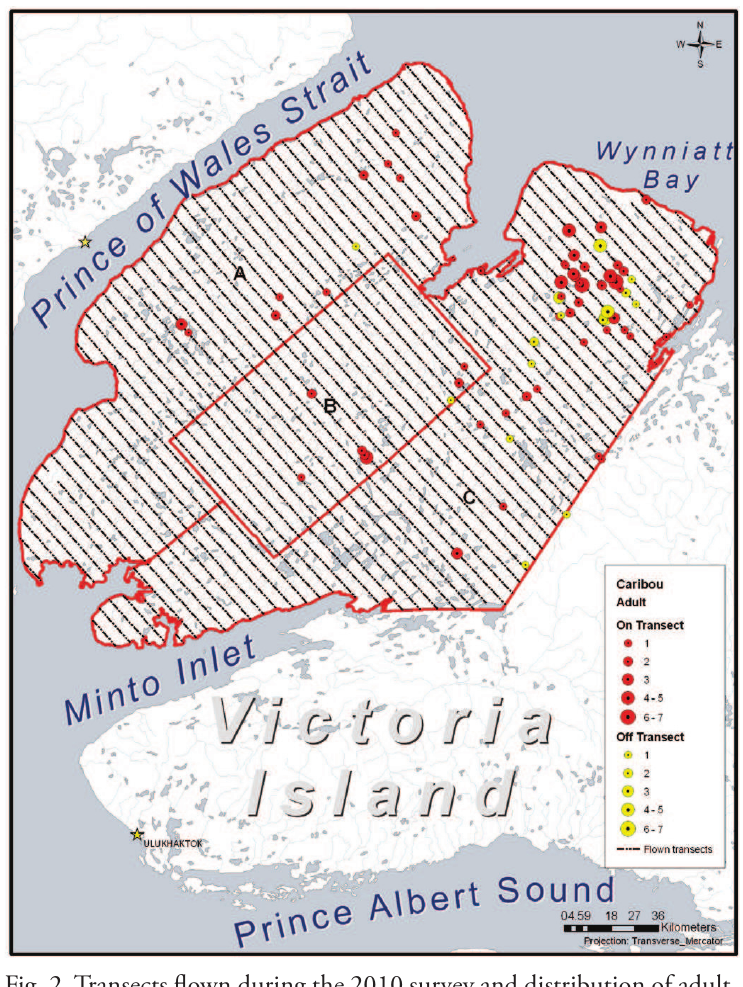
Fig. 2. Transects flown during the 2010 survey and distribution of adult caribou found ‘on’ and ‘off’ transect on northwest Victoria island,